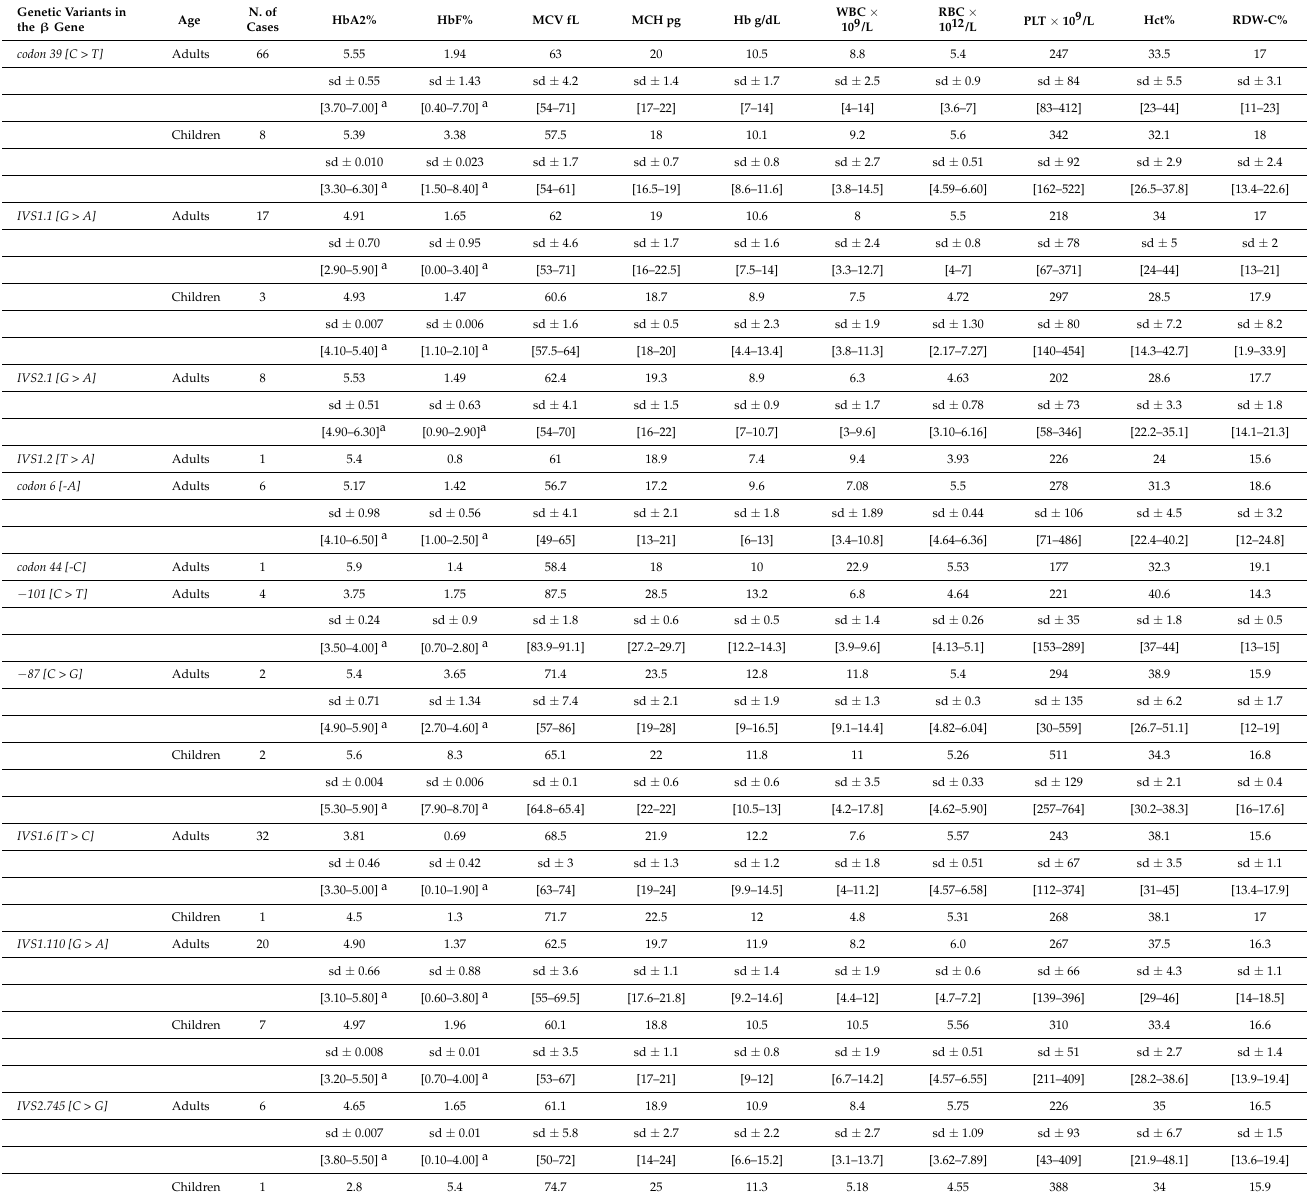
Table 4. Hematologic parameters (mean values and Standard Deviation (SD)) observed in subjects with mutation of the β -globin